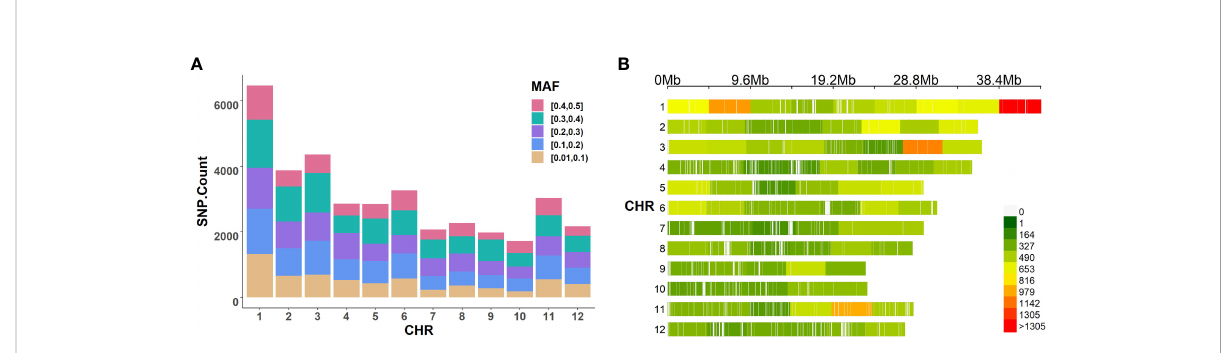
FIGURE 2 The distribution of SNPs in rice. (A) The distribution of minor allele frequency. (B) The density distribution of SNPs.